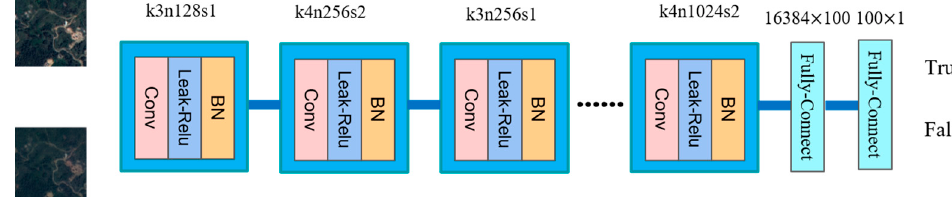
Figure 5. Network Structure of the Discriminator Network.